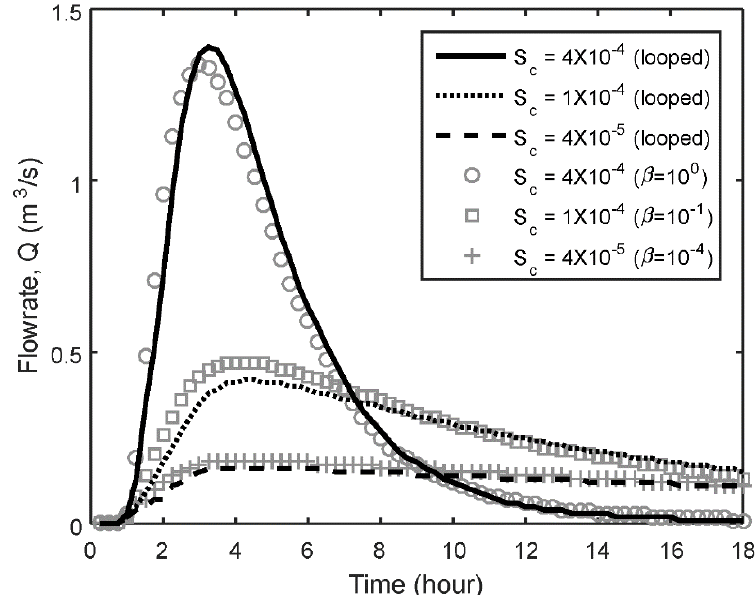
Figure 4. Comparison of the flow hydrographs from a fully looped network and dendritic networks generated by the Gibbsian model depending on the catchment slope (rainfall intensity = 15